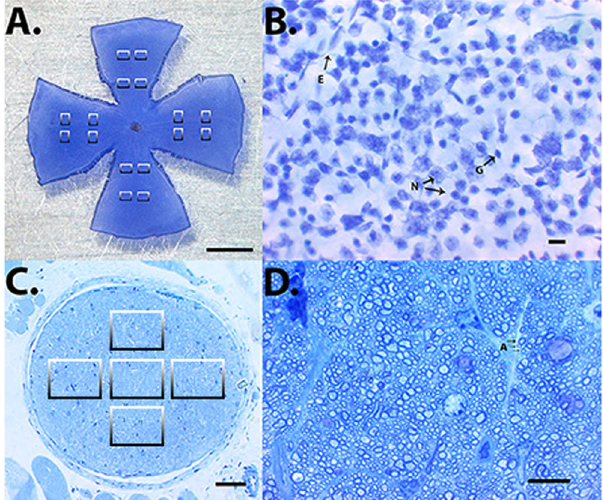
Figure 1. Photographs were taken from 16 pre-defined areas of wholemount stained with cresyl blue ( A ; scale bar 1 mm). In each photograph ( B ; scale bar 10 µ m), the individual cell types were identified and separately counted (E: endothelial cell; G: glial cell; N: neuron). In optic nerve cross sections ( C ; scale bar 50 µ m) the axon number (A: axon) was counted in 5 microphotographs taken from 5 pre-defined areas ( D ; scale bar 10 µ